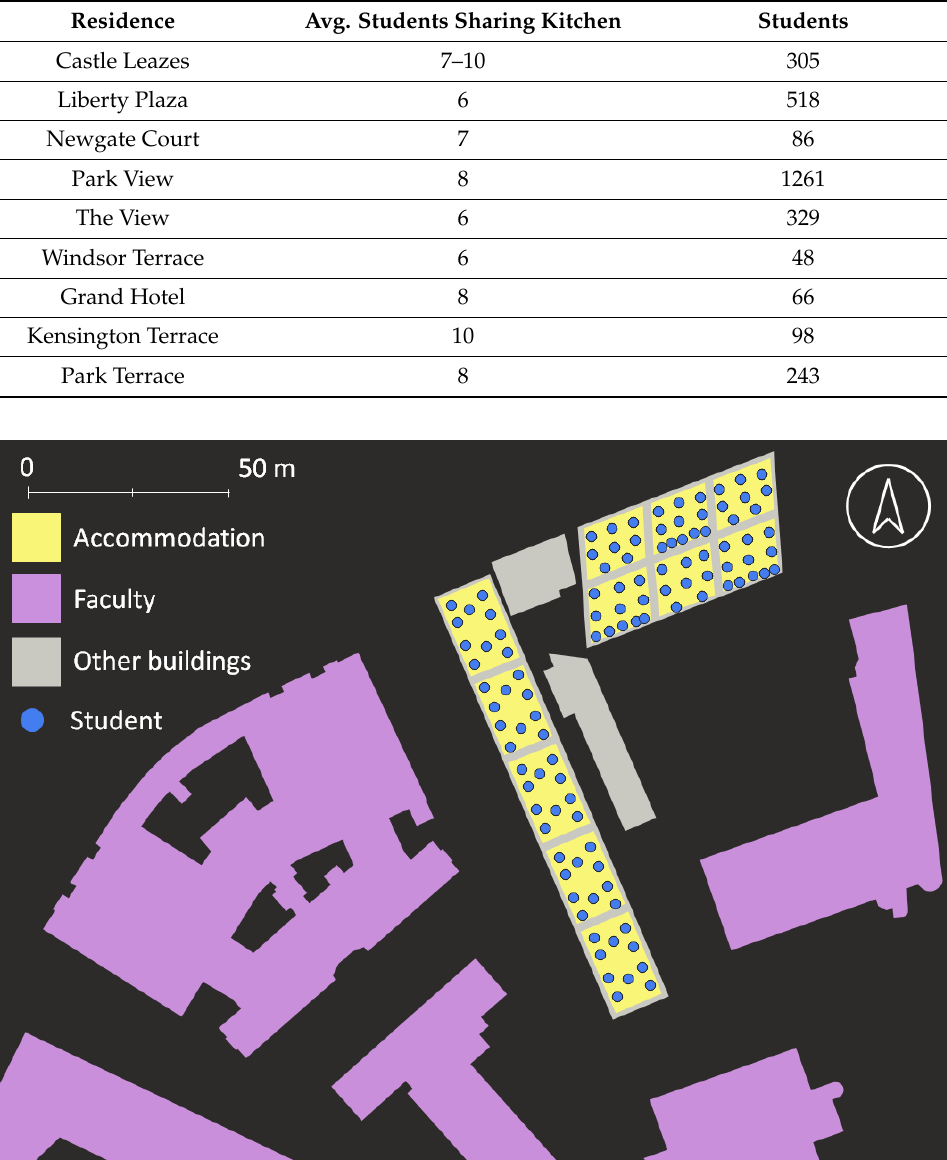
Table 2. Student accommodations selected in the project.